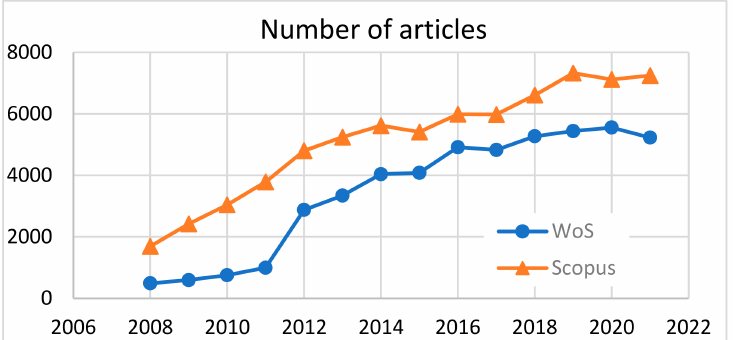
Figure 2. Number of published articles in the WoS and Scopus database (search for the topic “wind